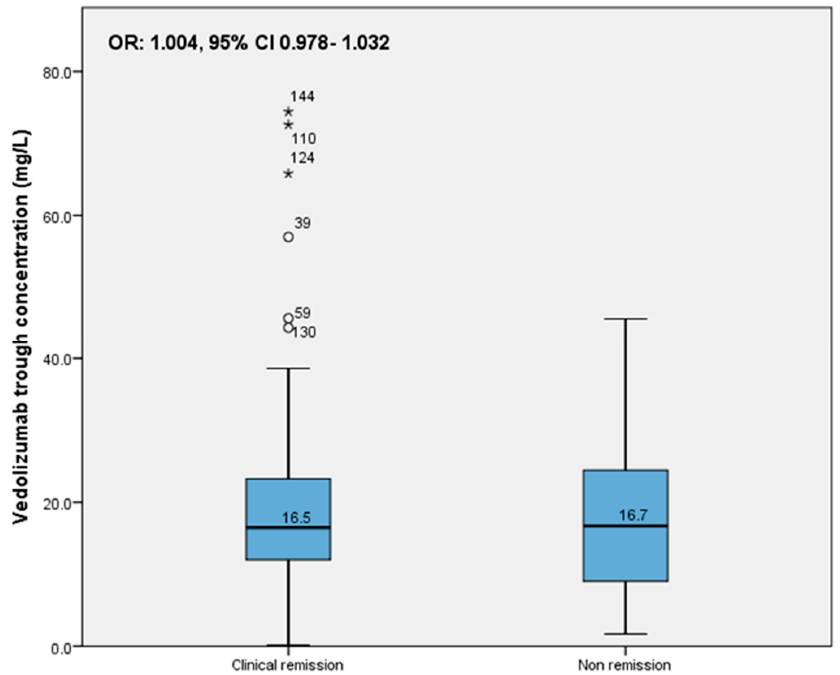
Figure 3. Association of trough concentration with clinical remission in total IBD group. ( ◦ indicates an outlier in the dataset, * indicates there is an extreme outlier in the dataset)